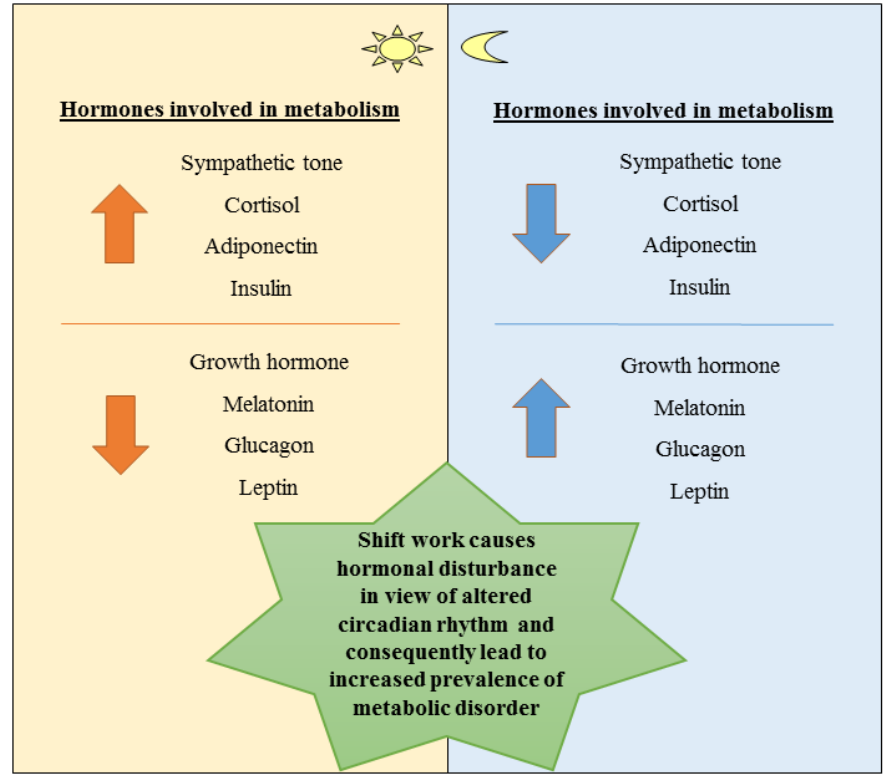
Figure 2. Schematic diagram showing effect of different hormones based on circadian rhythm. Adapted from Bass et al. (2010) [112].